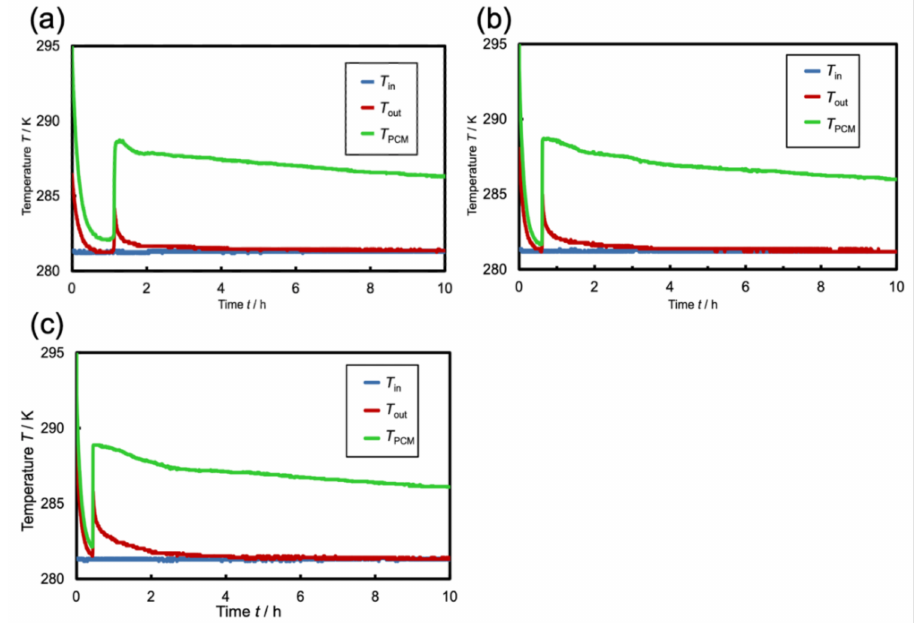
Figure 6. Time evolutions of the temperature at inlet of the chiller (T in ), outlet (T out ) of the chiller and thermal energy storage medium (T PCM ) in the system with the mechanical agitation. ( a – c ) depict each curve at the agitation rate of 100 rpm, 300 rpm and 600 rpm, respectively.